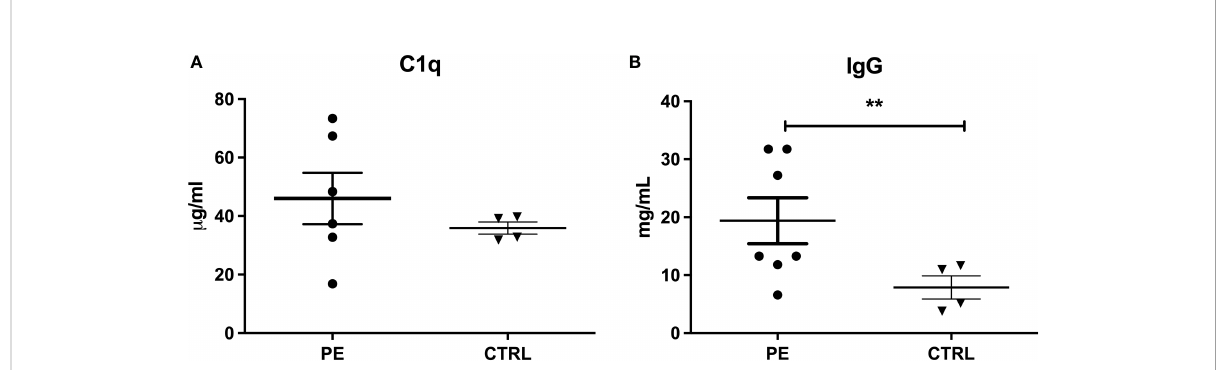
FIGURE 2 Detection of C1q and IgG on STBM. Analysis of C1q (A) and IgG (B) bound to STBM was performed by Sandwich ELISA, solubilizing the microvesicles derived from pre-eclamptic (PE, n=7) and control (CTRL, n=4) placentae. No statistical differences were observed between PE and CTRL STBM (Mann-Whitney U-test) as regard to the presence of C1q, whereas greater amount of IgG was found deposited on PE STBM compared to those derived from CTRL placenta. Bars represent mean ± standard error. (**p<0.01,